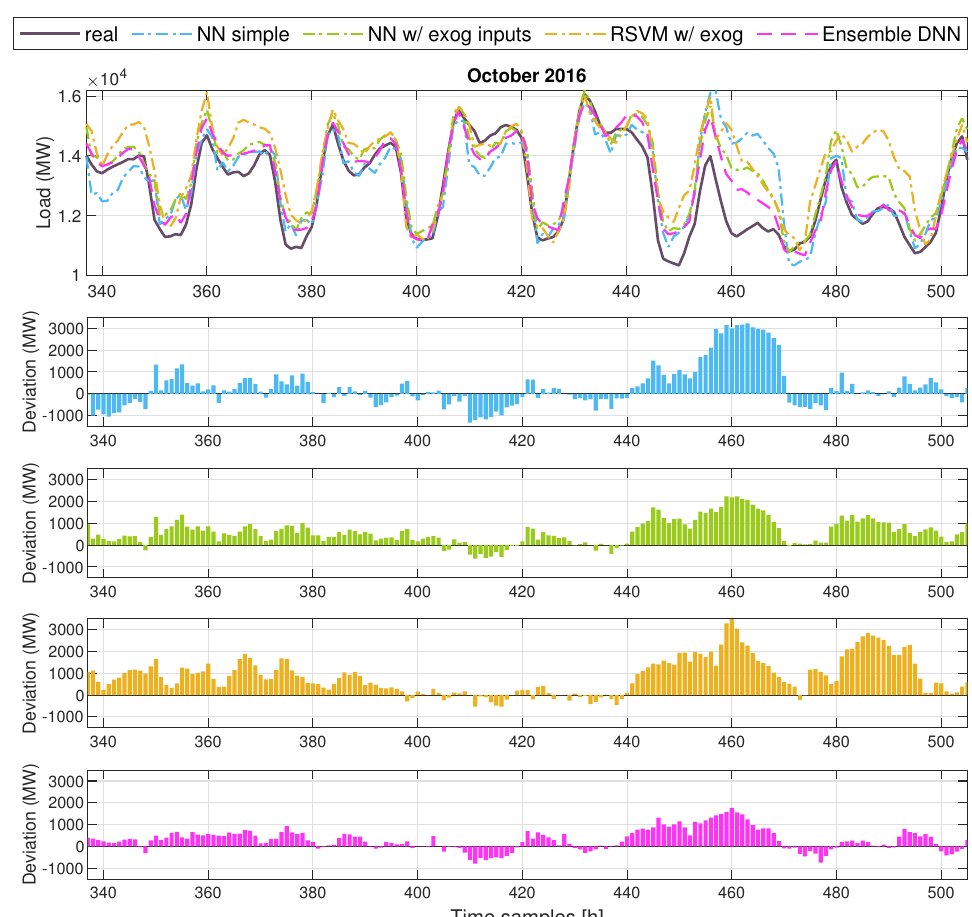
Figure 8. Predicted loads vs. real load and the respective mean deviation (signed error) of each method: 3rd week of April